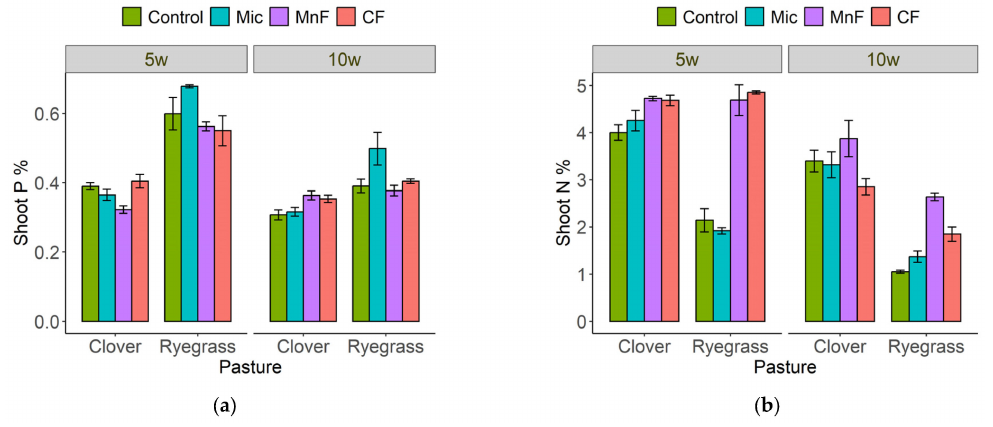
Figure 3. Shoot P (%) ( a ) and shoot N (%) ( b ) for subterranean clover and annual ryegrass grown separately at 5 and 10 weeks. Treatments were untreated soil (control), rock mineral fertilizer (MF), chemical fertilizer (CF) and microbial inoculant (Mic). Results are presented as means + standard